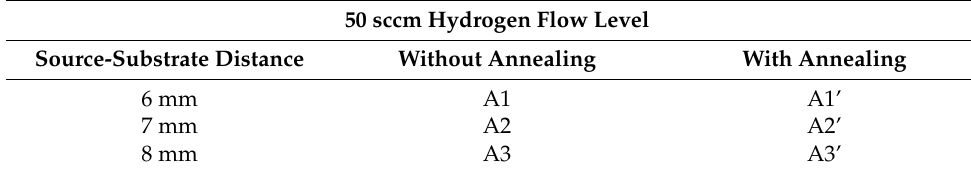
Table 1. Description of the six SRO film